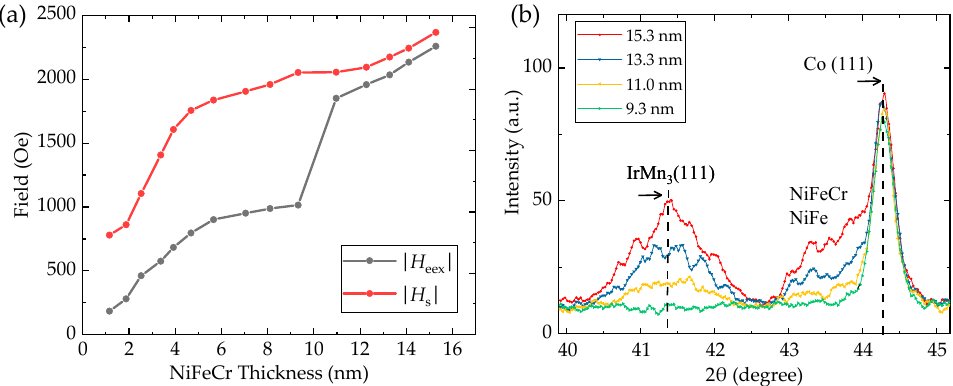
Figure 4. ( a ) Evolution of H eex and H s (in absolute values) with NiFeCr thickness; ( b ) intensities of IrMn 3 (111) peak in the film with different seed layer thicknesses.